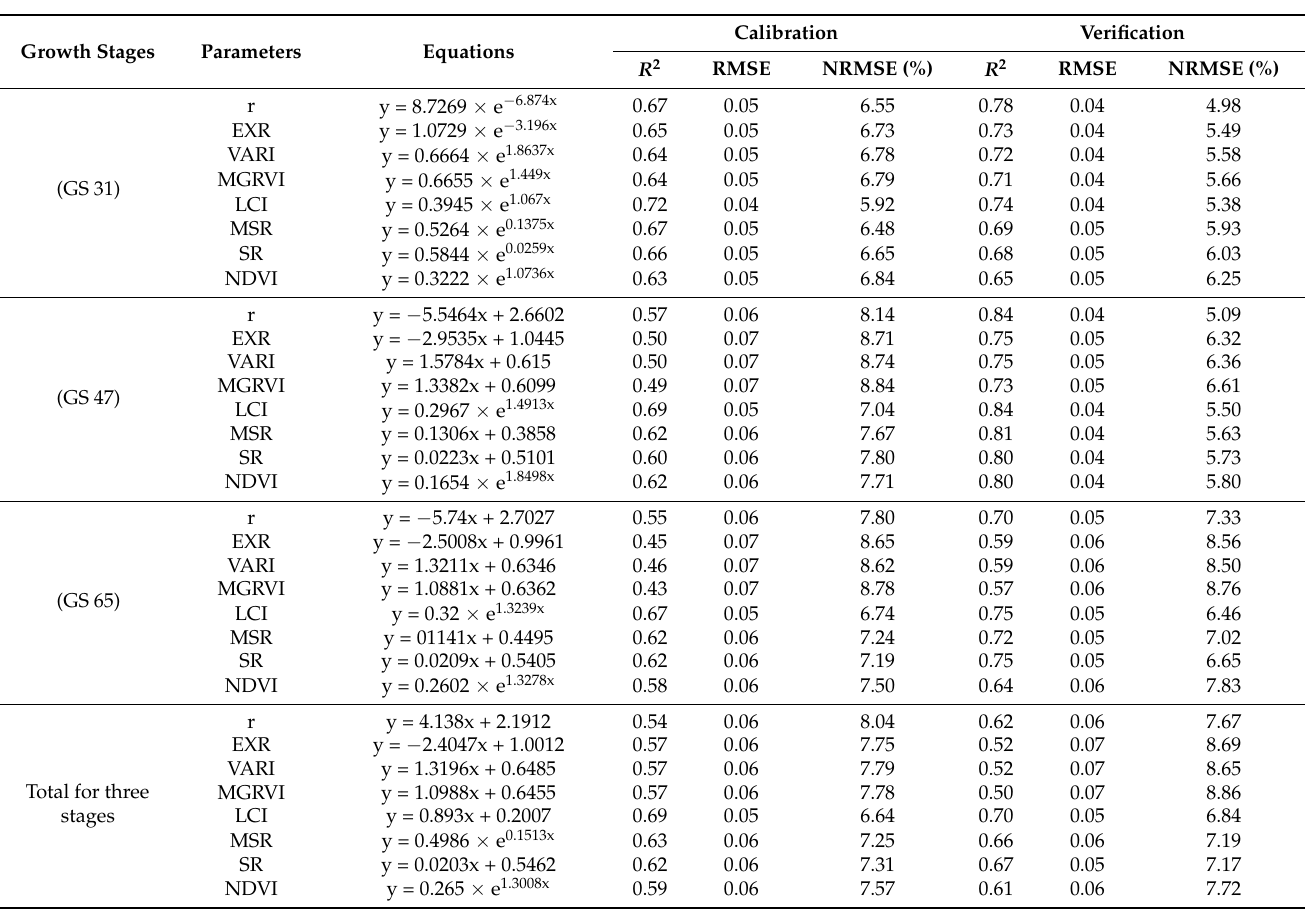
Table 4. CGI estimation model for the single index of winter wheat in different